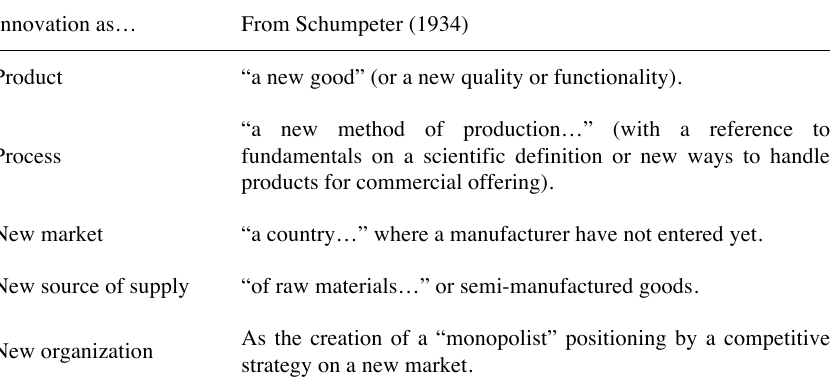
Table 1. Innovation concepts Innovation as… From Schumpeter